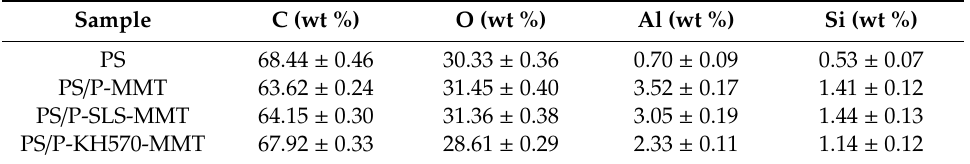
Table 3. Distribution of the elements in PS, PS / P-MMT, PS / P-SLS-MMT, and PS / P-KH570-MMT samples found by EDS measurement related with SEM images given in Figure 9.